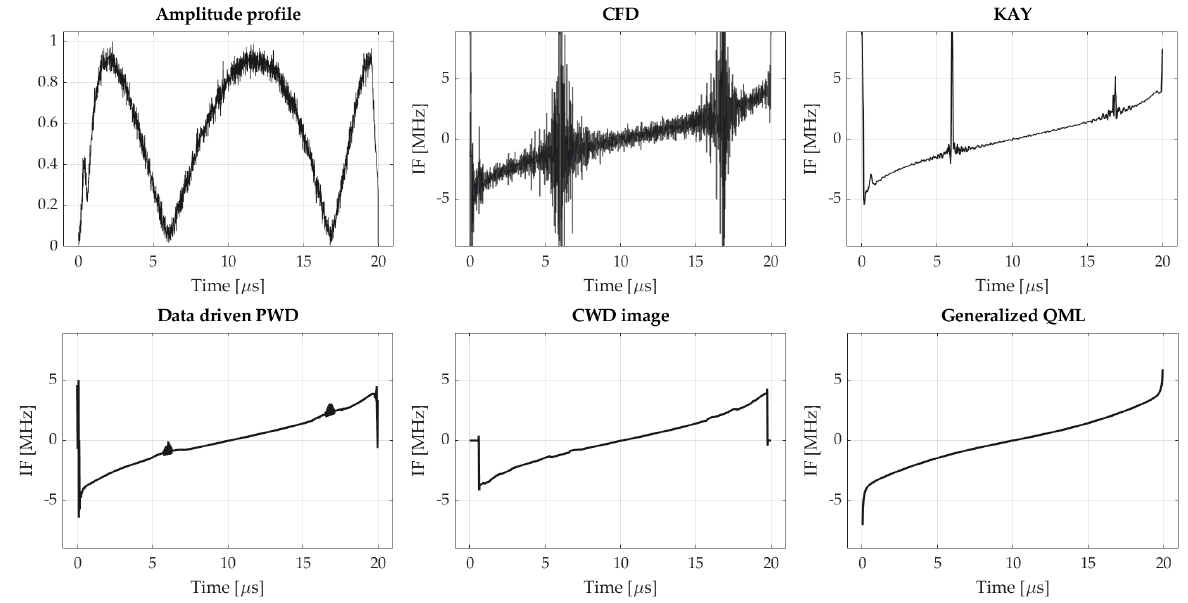
Figure 10. Instantaneous frequency estimates for the NLFM pulse affected by multipath. The envelope of resultant pulse is also shown to give better understanding of the phenomenon. SNR = 20 dB. True IF-law is the same as one presented in Figure 7. It can be noted that for a considered time, the phase and amplitude relationship between the direct-path and reflected pulse, the envelope of the resultant pulse (seen by